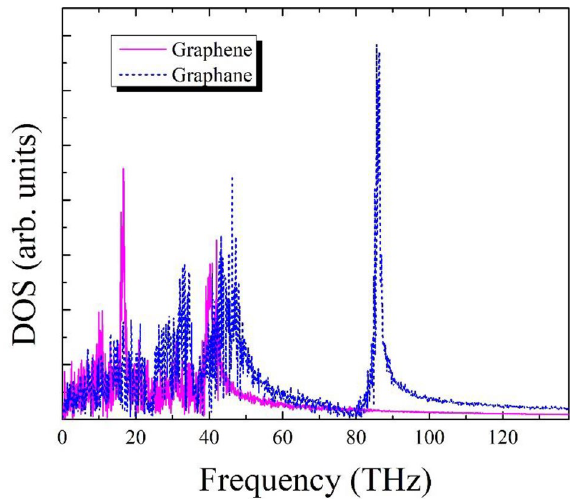
Figure 6. Phonon density of state (DOS) on two sides of graphene (left) /graphene (right) hybrid nanoribbon interface having a length of 20.42 nm at T = 300 K and ΔT = 40